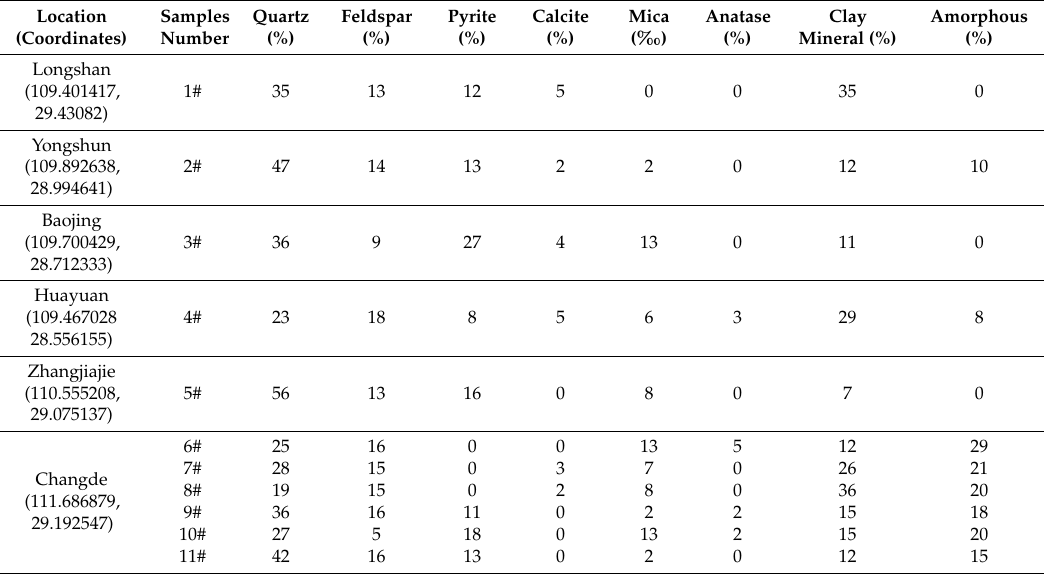
Table 1. The mineral composition of outcrop shale in the target area.